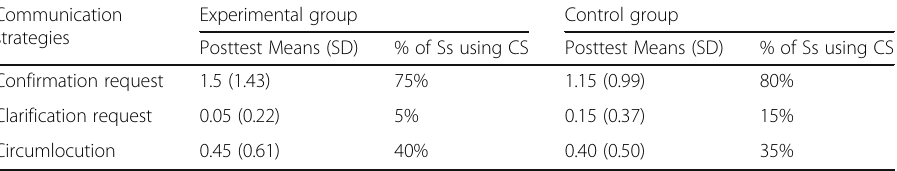
Table 4 Means and standards deviations of different communication strategies used by the experimental